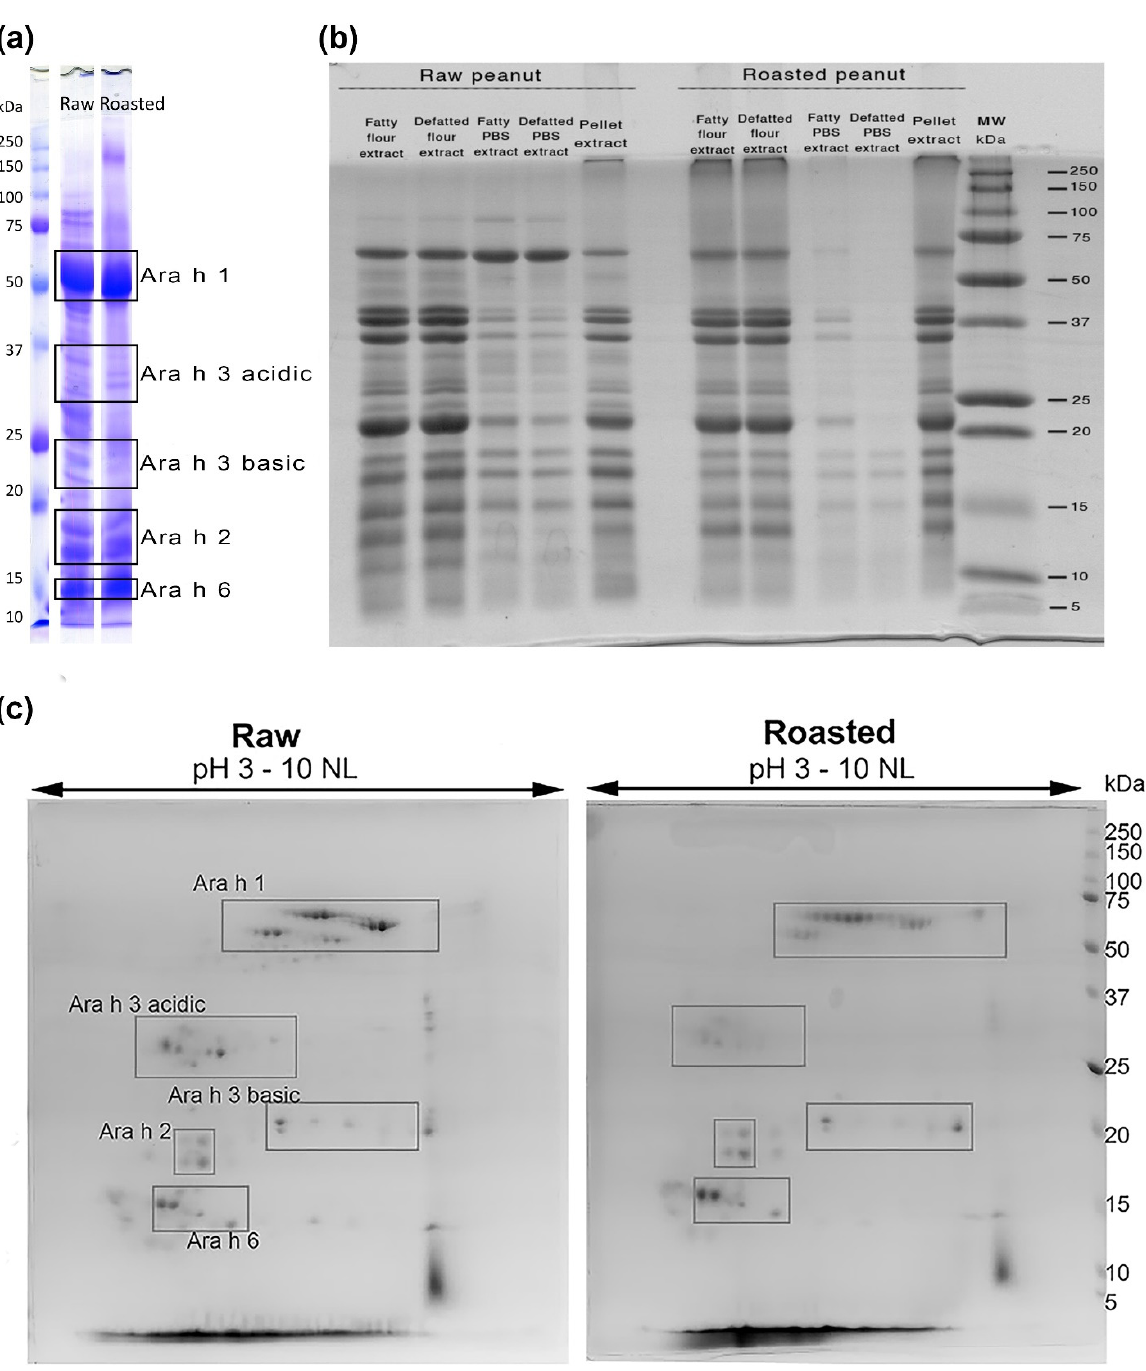
Figure 1. Raw and roasted PBS-based peanut extract (PEs) protein profiles. ( a ) Sodium dodecyl sulfate polyacrylamide gel electrophoresis (SDS-PAGE) of peanut extracts (100 µ g per lane) resolved on 12% polyacrylamide gel in reducing conditions. The grey boxes denote gel pieces excised and analyzed by nLC-MS/MS. ( b ) SDS-PAGE profiles of insoluble and soluble fractions analyzed with the equal volumes of raw and roasted peanuts. SDS-PAGE of the non-defatted and defatted crude peanut paste was obtained in reducing conditions by Laemmli buffer, phosphate-buffered saline (PBS) extracts were prepared from non-defatted and defatted peanut flour, while pellet extract was obtained by pellet extraction with denaturing buffer. ( c ) 2D SDS-PAGE protein profiles of raw and roasted peanut extracts.